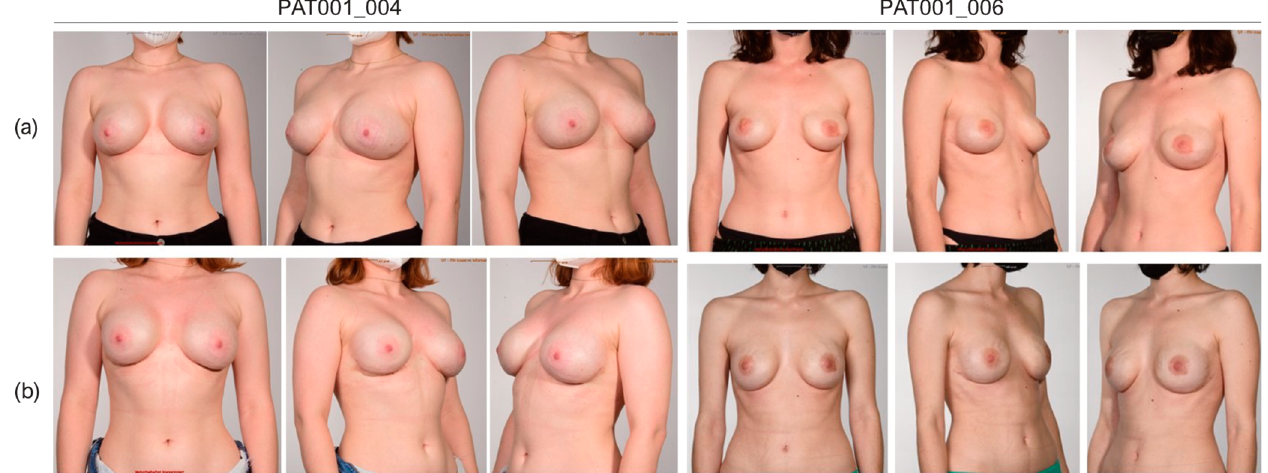
Figure 5. Photo documentation for cosmetic evaluation after the ( a ) first (PAT001_004 and PAT001_006; left breast: Mentor ® CPX4, right breast: SmoothSilk ® ) and ( b ) second reconstructive stage (PAT001_004: Motiva Ergonomics SmoothSilk ® , 450 cc, full projection, and PAT001_006: Motiva Ergonomics SmoothSilk ® , 340 cc implants, demi).